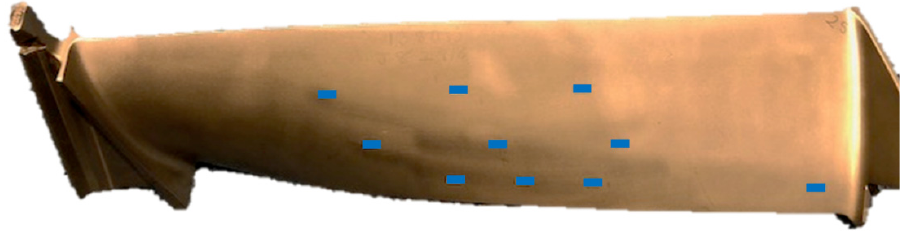
Figure 15. 3D printed sensors integrated turbine blade [105].